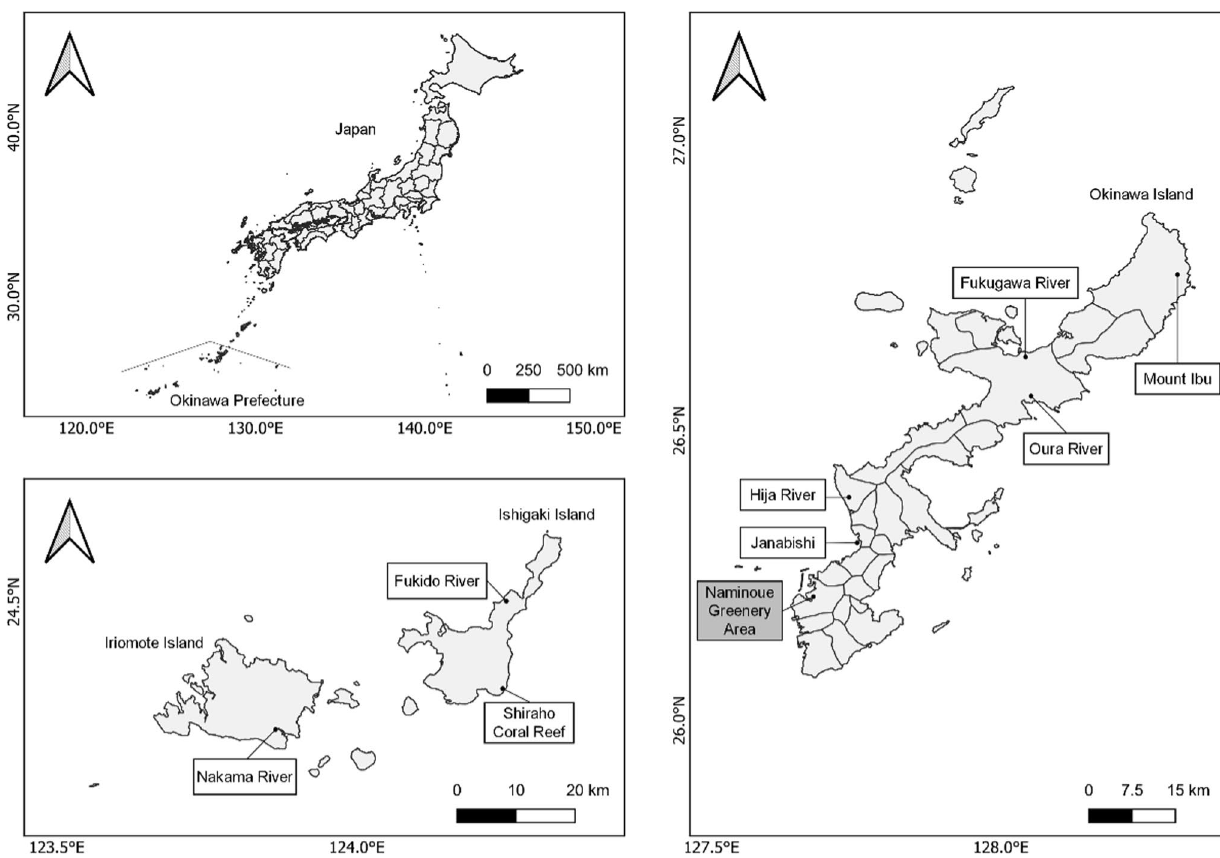
Fig. 1 Locations of CUAs in Okinawa Prefecture. Source: Author . Naminoue Greenery Area, Fukido River, Oura River and Shiraho Coral Reef are expired CUAs as of May 2022. Naminoue Greenery Area is not included in Table